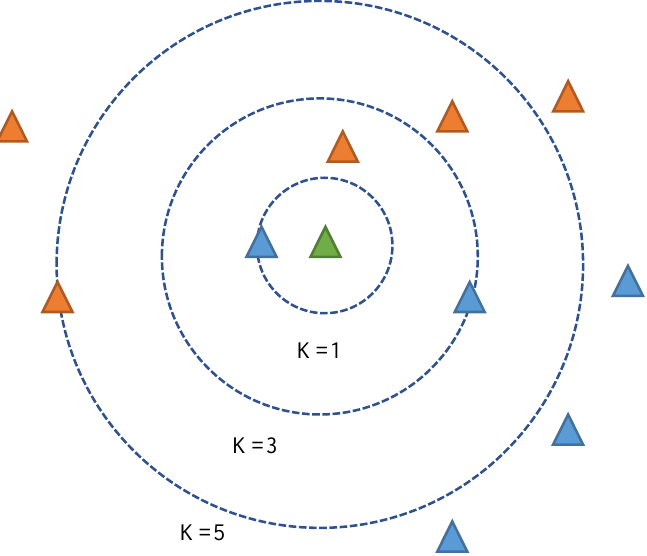
Figure 4. Graphic depiction of a k-nearest neighbors (kNN) classification model.